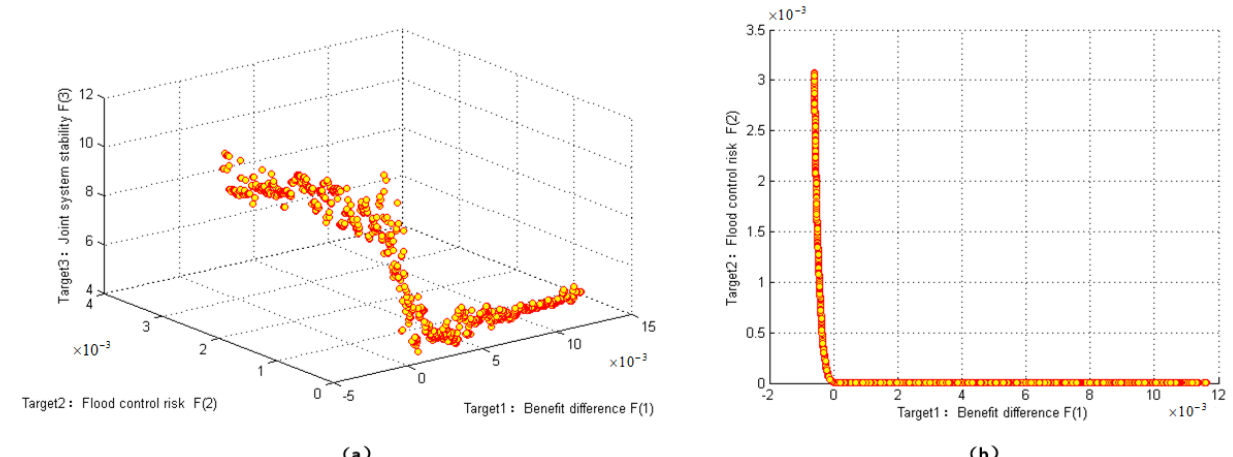
Figure 12. Pareto frontier of the scheduling scheme considering system output volatility. ( a ) Pareto frontier under three objectives. ( b ) Pareto frontier under two objectives.